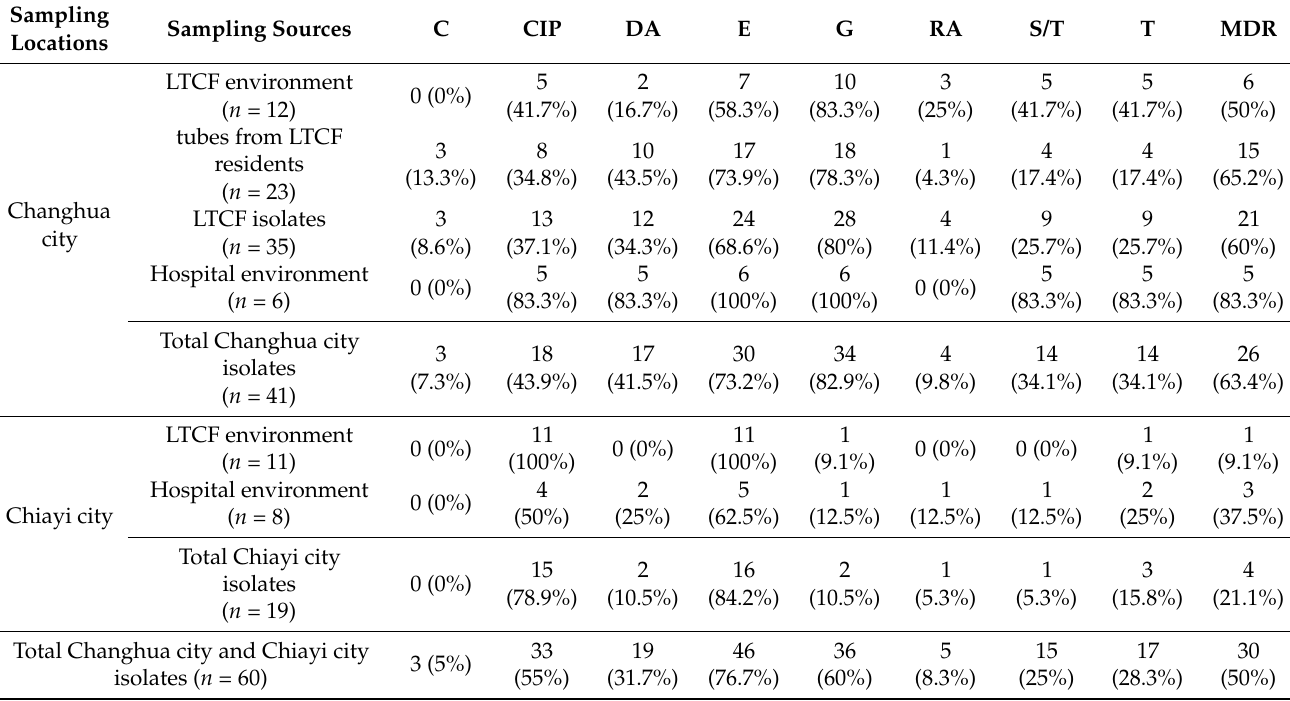
Table 4. Antimicrobial susceptibility results of the 60 MRSA strains.